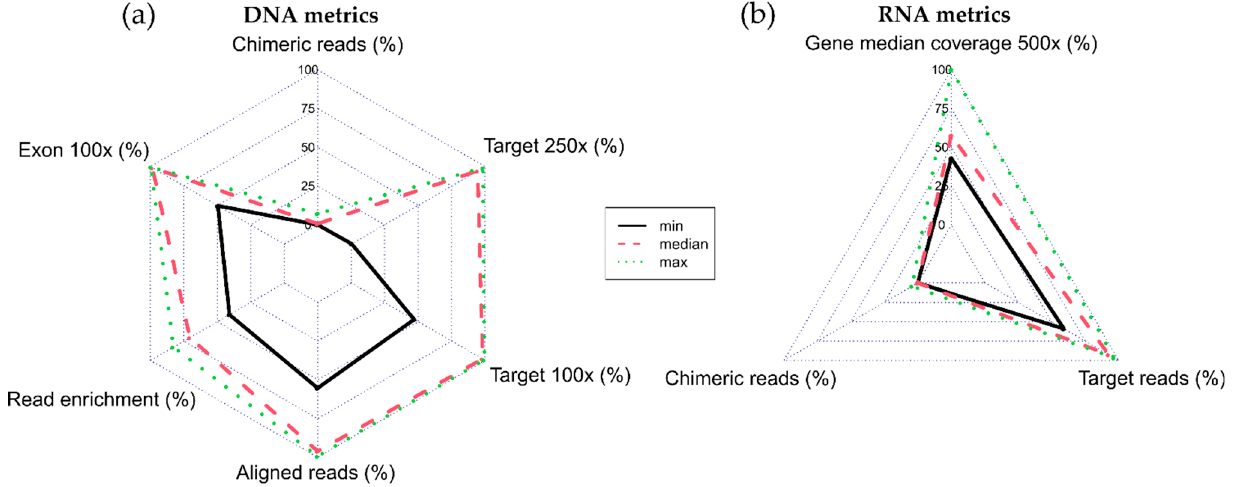
Figure 4. Radar plot reporting sequencing coverage and mapping quality metrics for 71 DNA ( a ) and 59 RNA ( b ) samples.